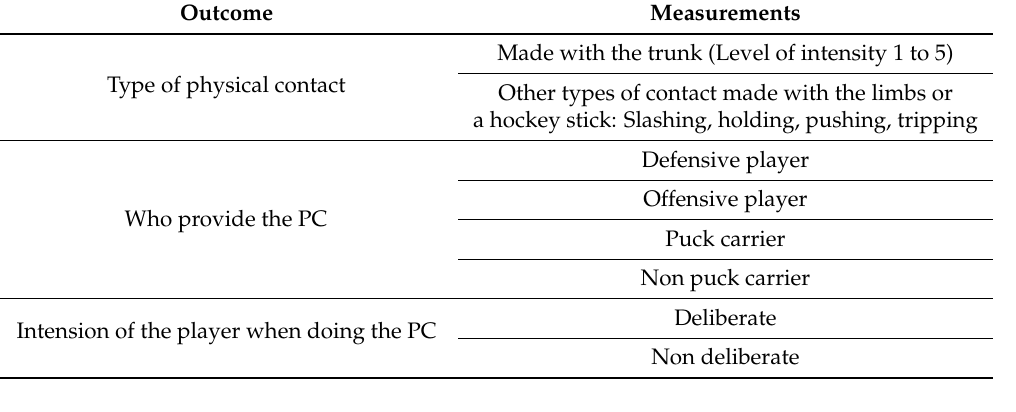
Table 1. Characteristics of the physical contact (PC) observed.